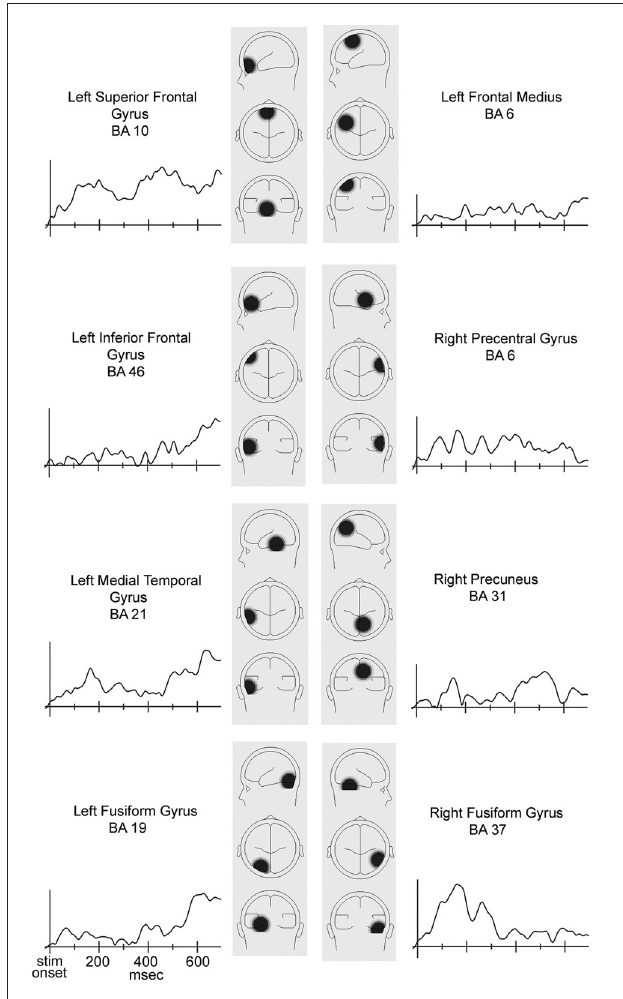
FIGURE A1 | Maps and activation magnitude waveforms for the eight sources from the BESA source estimation for the across-subjects averaged congruent-incongruent difference waves. The data were from the seven subjects with positive IAT scores. Note that six of the electrode sites (F11, F12, T7, T8, P9, and P10) in the 33 electrode montage were located below the estimated locations of the deepest sources.